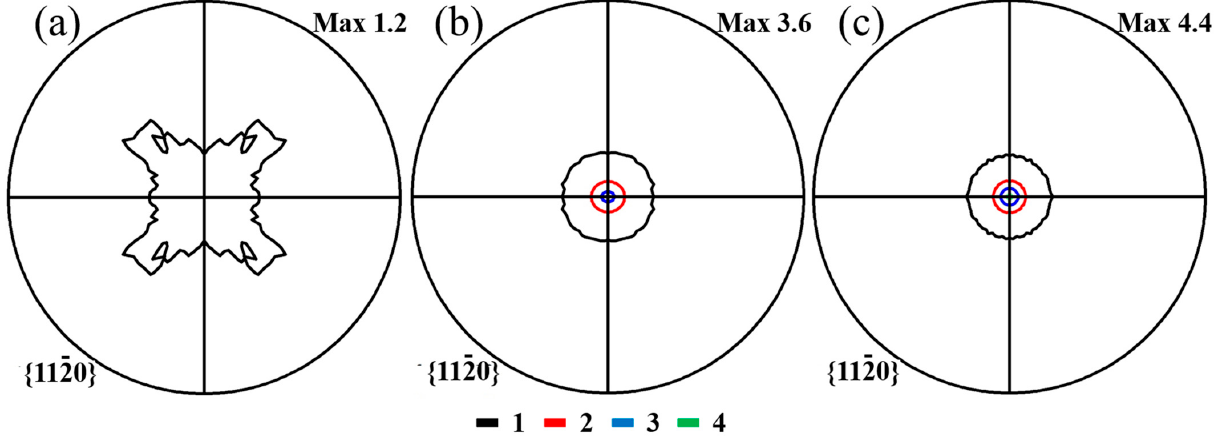
Figure 2. Measured 1120 PFs by XRD for Sb 2 Te thin films (200 nm) annealed at ( a ) 140 °C; ( b ) 200 °C; ( c ) 400 °C. The holding time is 30 min. Different colors represent pole density levels: black for 1, red for 2, blue for 3, and green for 4. The green curve is a small circle at the center of ( c ). The maximum pole density is near the center of the measured PFs.